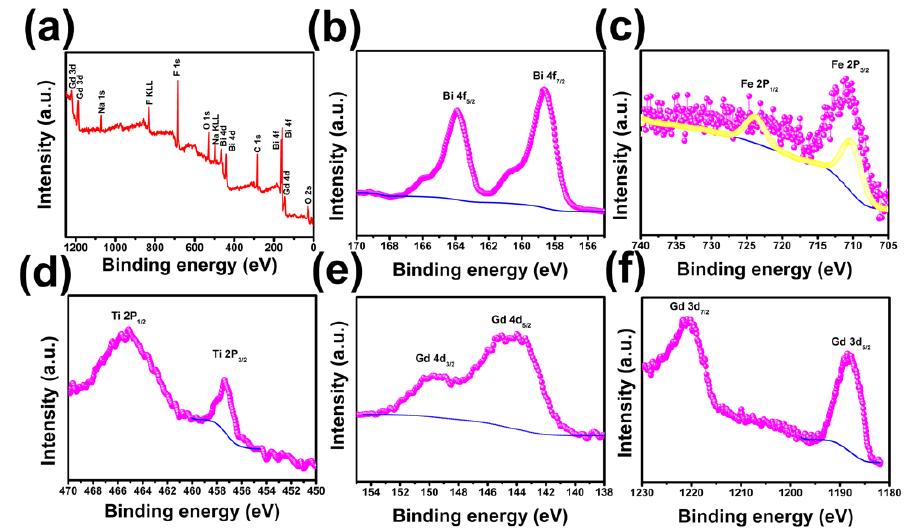
Figure 4. ( a ) The survey X-ray photoelectron spectroscopy (XPS) spectrum of the BFCTO-1.50/NGF nanocomposites; and high-resolution XPS spectra of ( b ) Bi 4f; ( c ) Fe 2p; ( d ) Ti 2p; ( e ) Gd 4d and ( f ) Gd 3d.